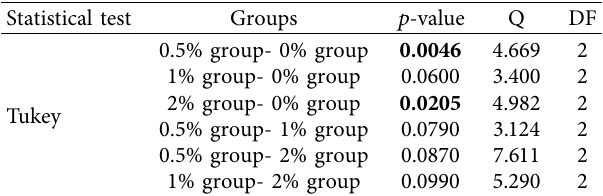
Table 4: Results for Tukey’s post hoc test hardness test between the groups (0.5%, 1%, and 2%) and 0% group. Statistical